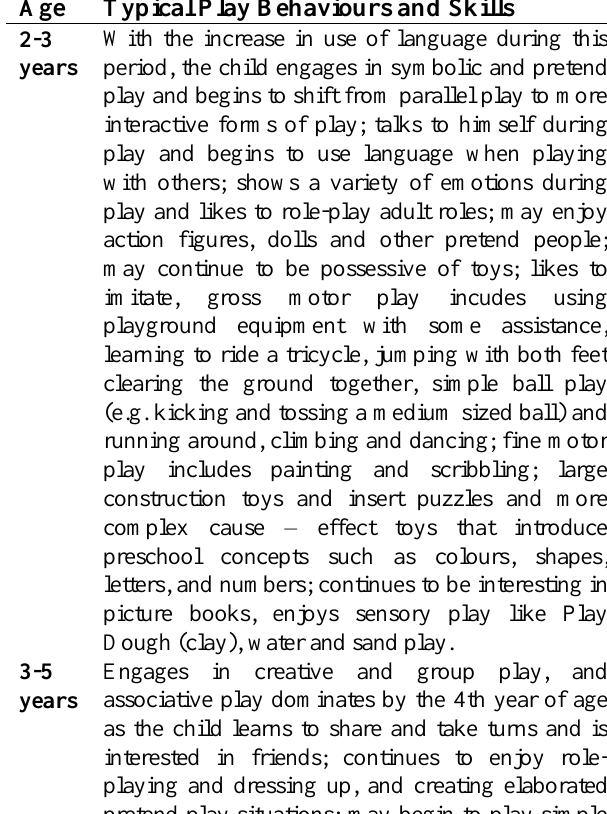
Table 1: Typical play behaviours and skills